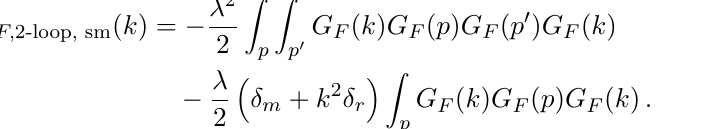
Figure 3 . (Left) One-loop contribution to the two-point correlation function in a λφ 4 theory. (Right) The corresponding δ m and/or δ r counterterm